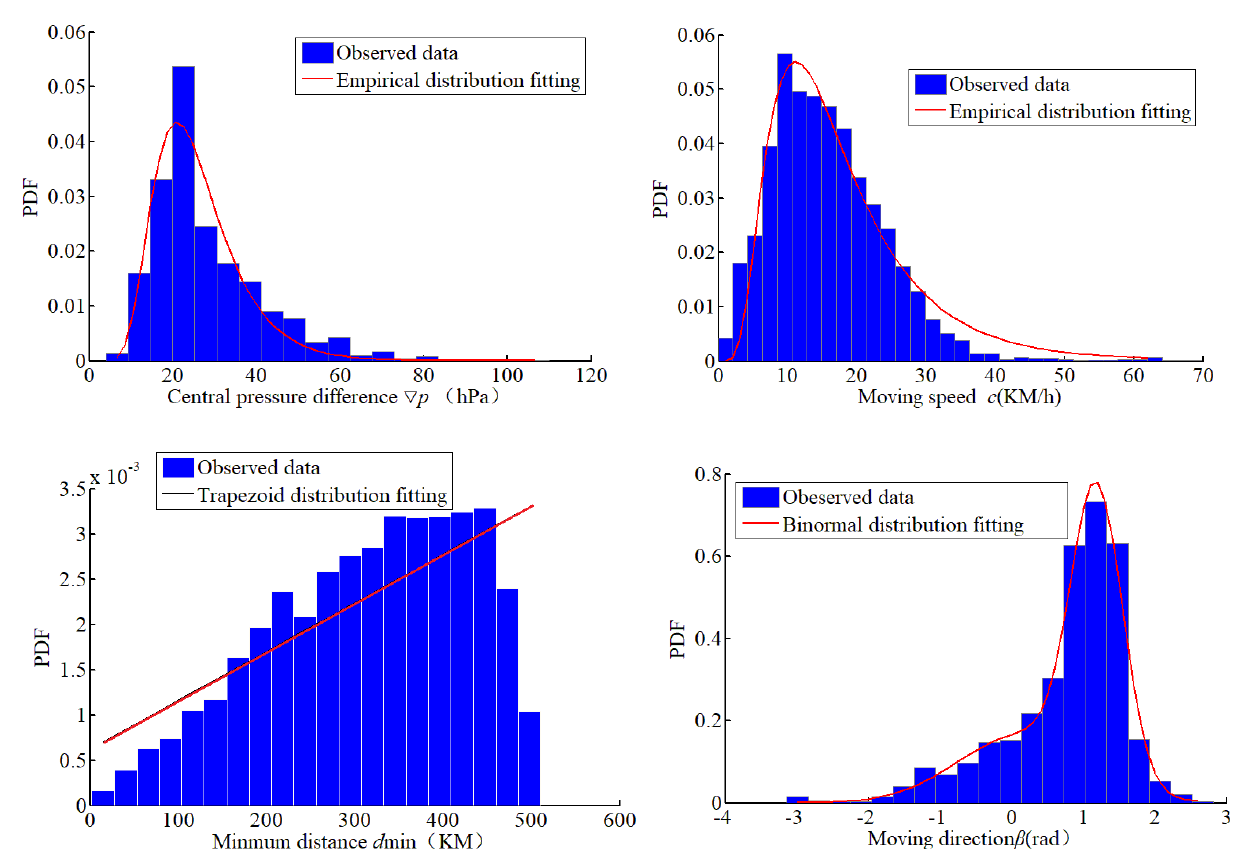
Figure 4. Fitting results of key parameters of typhoon in the wind farm of Shantou Yang Dong OWF.